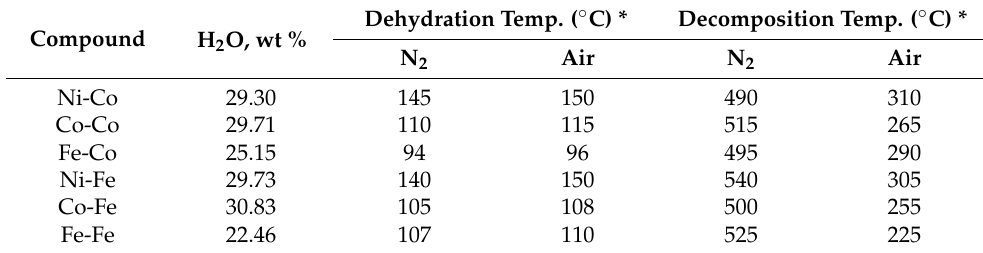
Figure 5. TG curves of the studied porous hexacyanometallates(III) in ( a ) inert atmosphere and ( b ) oxidizing atmosphere. Table 3. Degree of hydration, dehydration temperature, and decomposition temperature of the studied porous